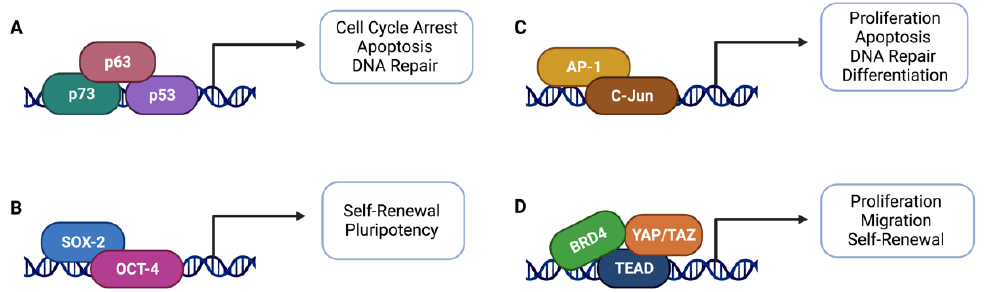
Figure 4. Transcriptional regulators in head and neck dysplasia: ( A ) p53, p63, and p73; ( B ) SOX-2 and OCT-4; ( C ) AP-1 and C-Jun; ( D ) BRD-4, YAP, TAZ, and TEAD. Created with